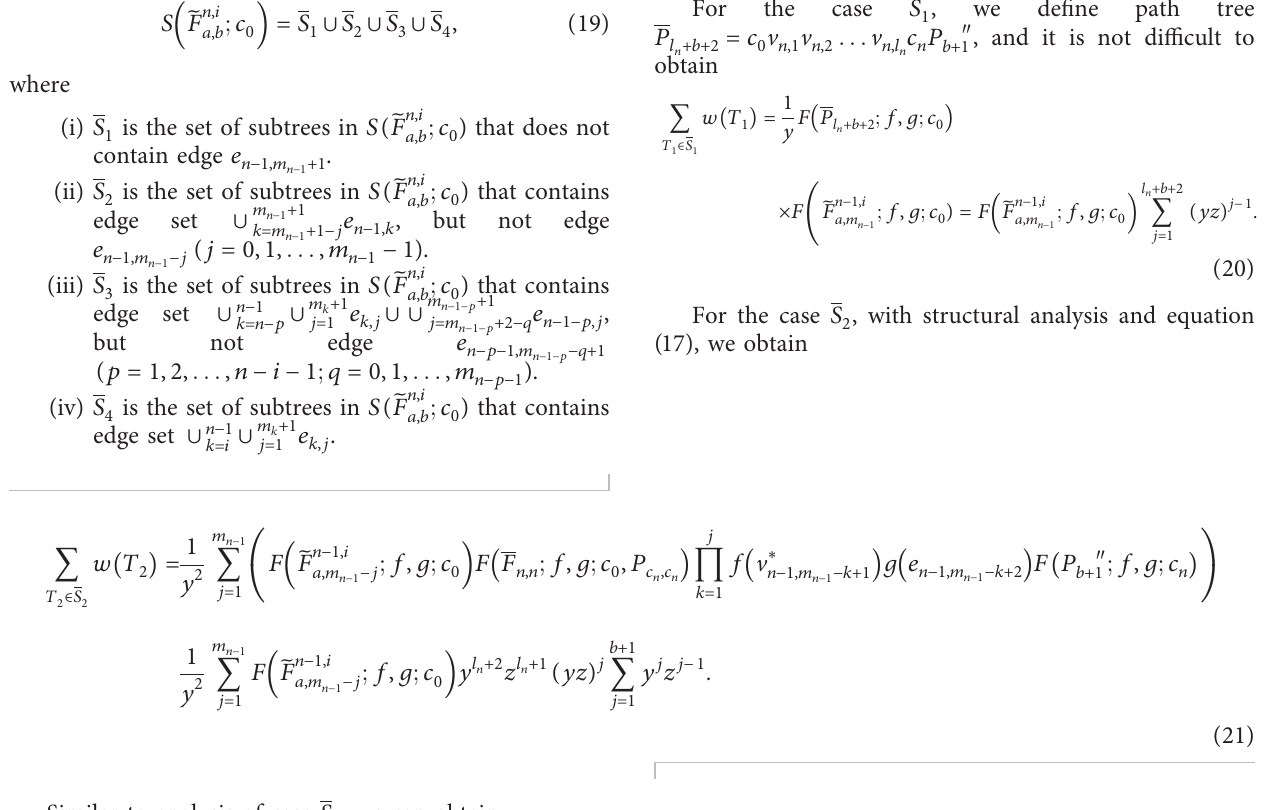
. (b) 􏽥 F 4 , 2 . (c) 􏽥 F 4 , 3 . (d) 􏽥 F 4 , 4 . 1 , 1 1 , 1 1 , 1 1 , 1